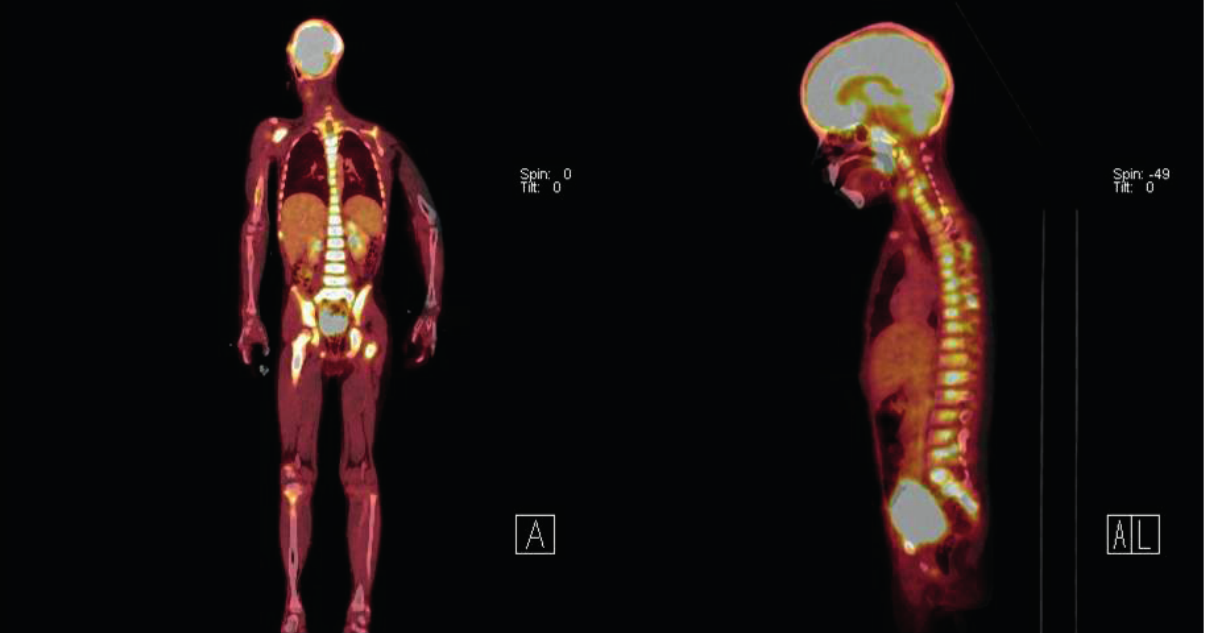
Fig. 2. integrated whole-body peT/cT scan using 18 F-FdG: anteroposterior and lateral projections. diffuse increase in